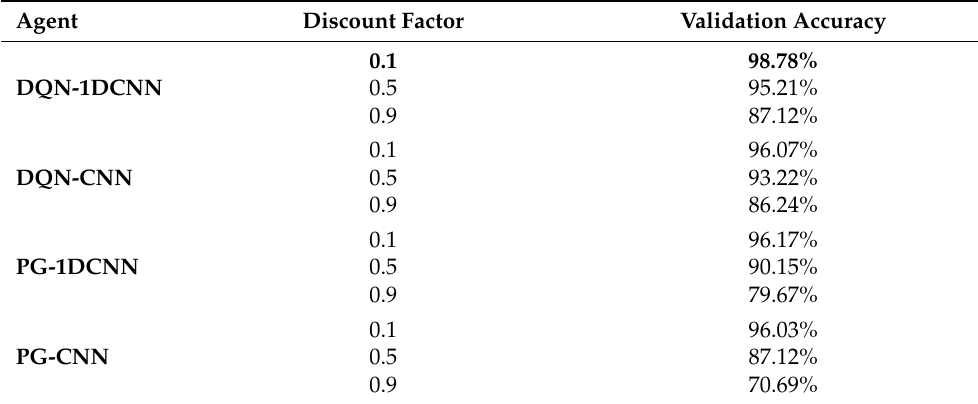
Table 10. Performances of different discount values on four agents.